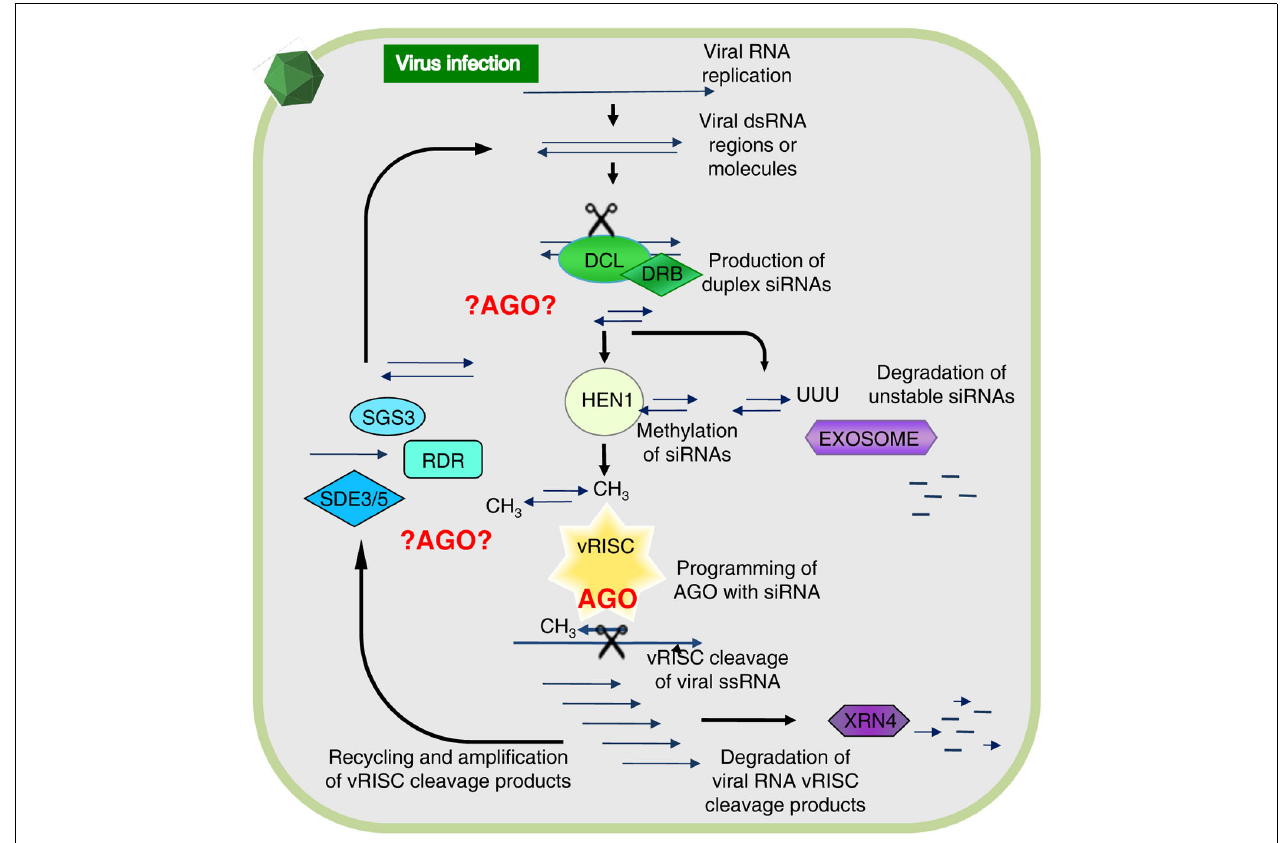
remains bound to an Argonaute protein (AGO) in vRISC and this operates as a search-and-strike module to cleave single-stranded (ss) RNA complementary to the siRNA.The resulting RNA fragments are either degraded via XRN4 or re-amplified by concerted action of SGS3, SDE3, SDE5, and an RNA-dependent RNA polymerase (RDR).The vRISC (star-shaped) associated AGO is indicated in red, whereas other possible AGO-mediated interactions alluded to in the text are denoted by ?AGO? Figure modified from Alvarado and Scholthof